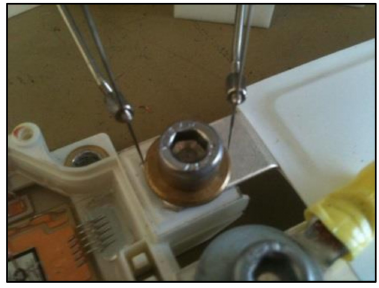
Figure 8. Resistance across the contact area measurement—module M.